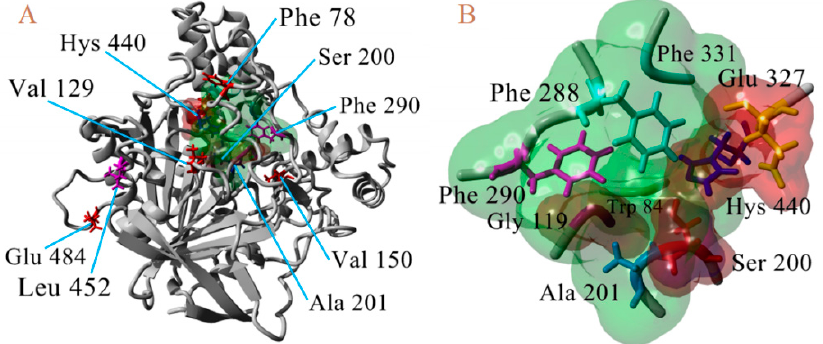
Figure 8. 3D atomic model of AChE, numbering of T. californica . ( A ). Location of waste susceptible to proposed point mutations. ( B ) Proximity of catalytic triad (Ser 200 , Hys 440 , and Glu 327 ).